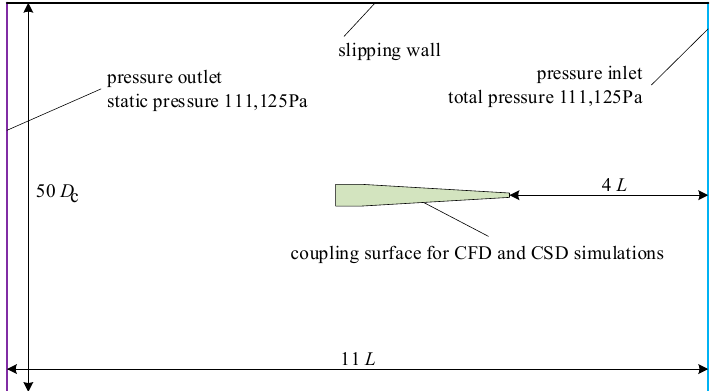
Figure 3. Schematic diagram of computational domain and boundary conditions.